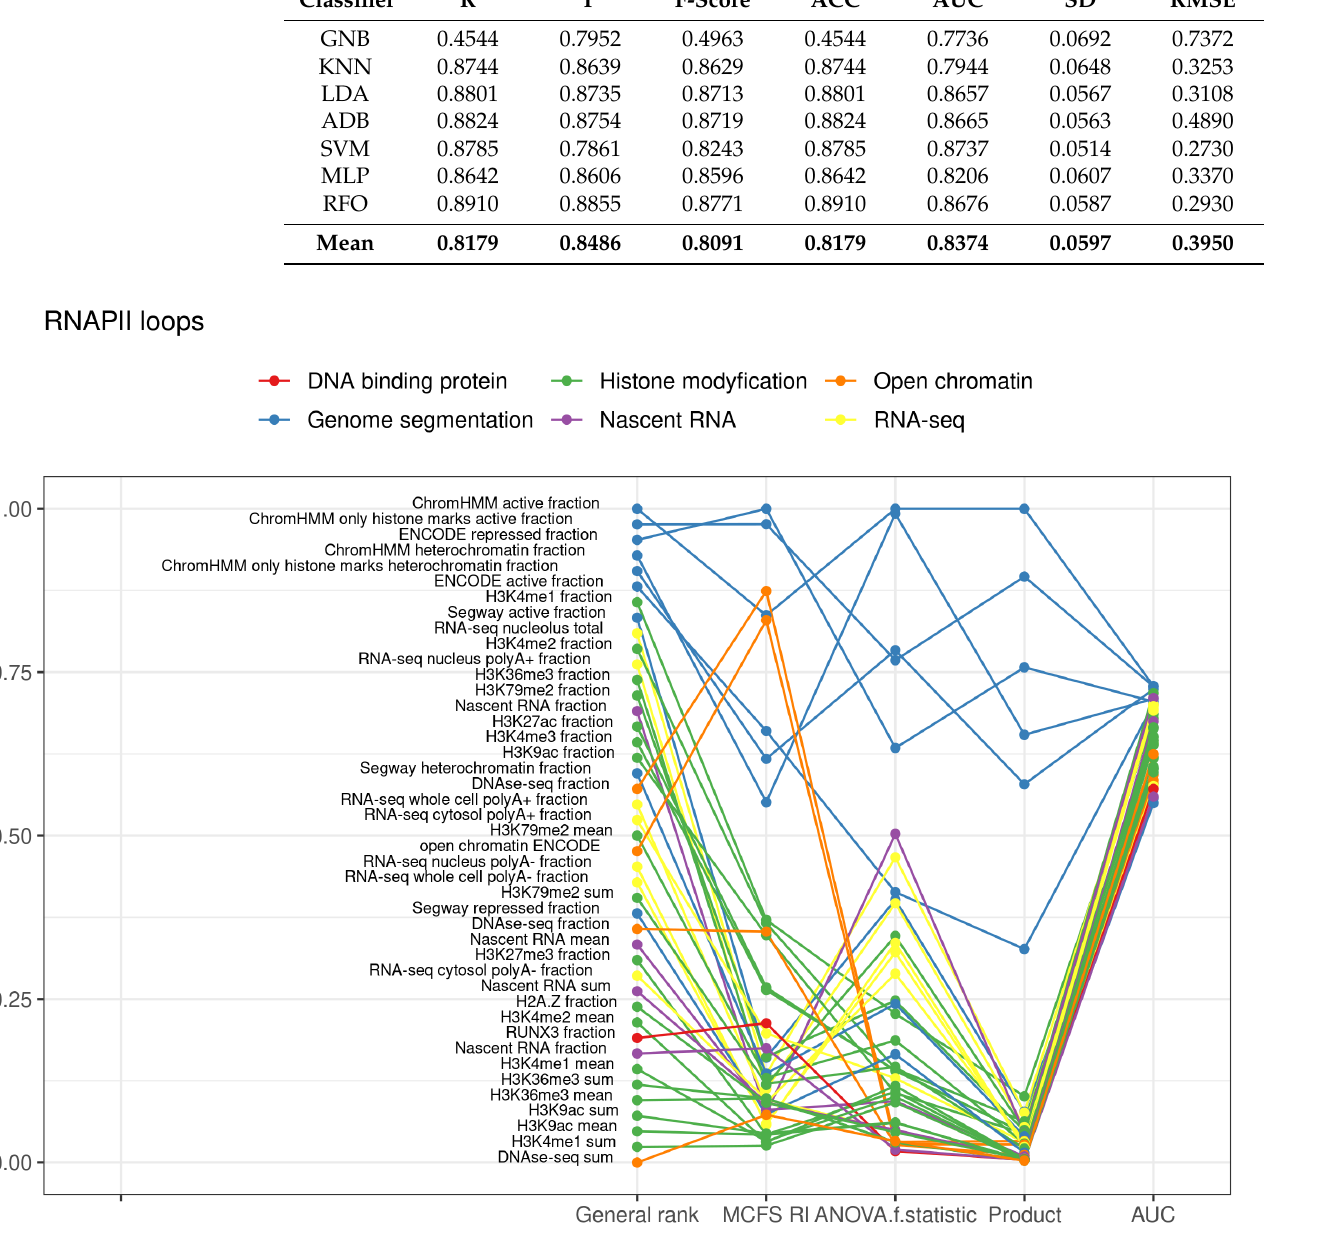
Figure 4. Top decile of most important features for classification of RNAPII loops into